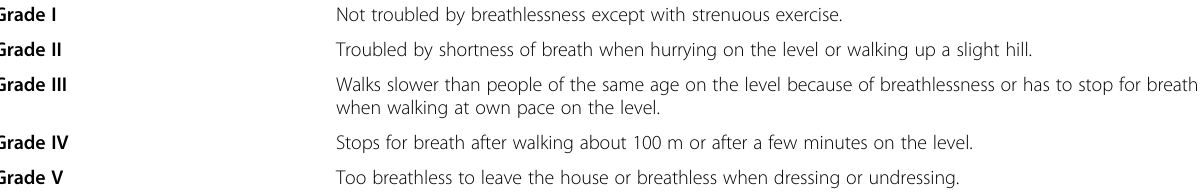
Too breathless to leave the house or breathless when dressing or undressing.